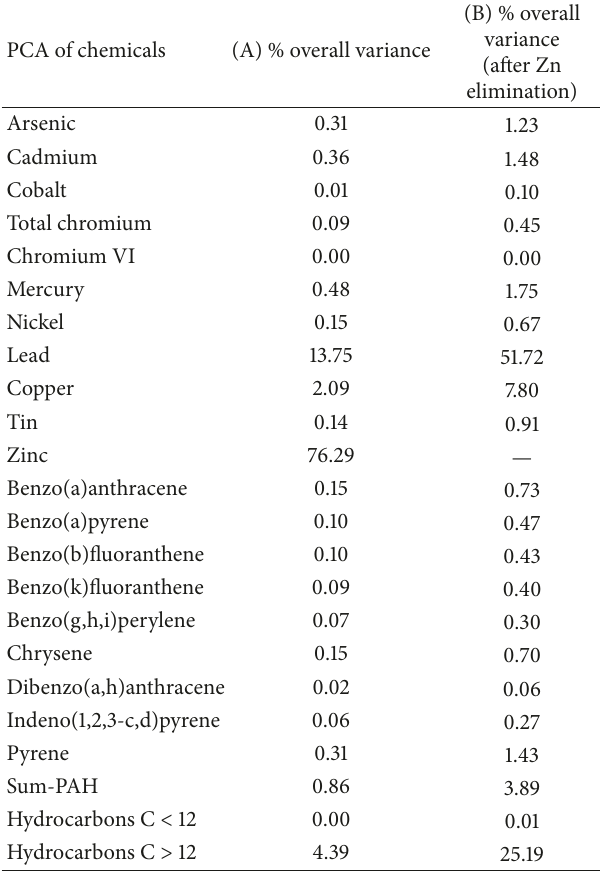
Table 2: Weights of each chemical on the overall